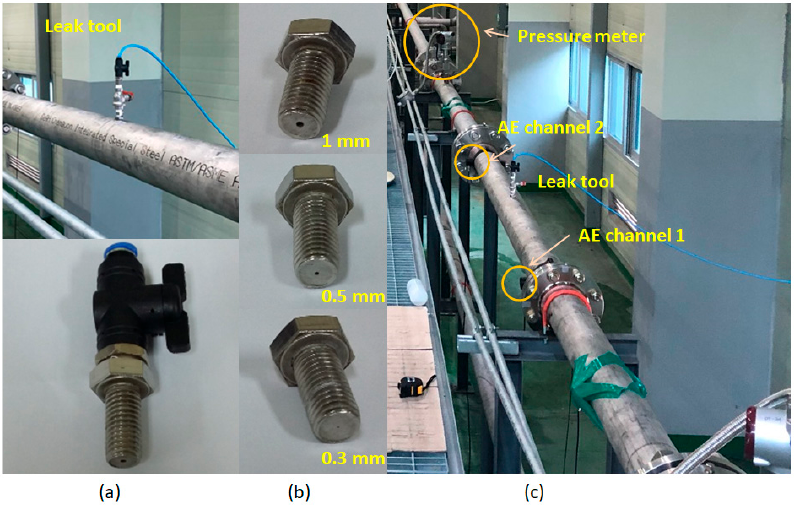
Figure 1. Pipeline testbed: ( a ) leak tool, ( b ) orifices, ( c ) test section .